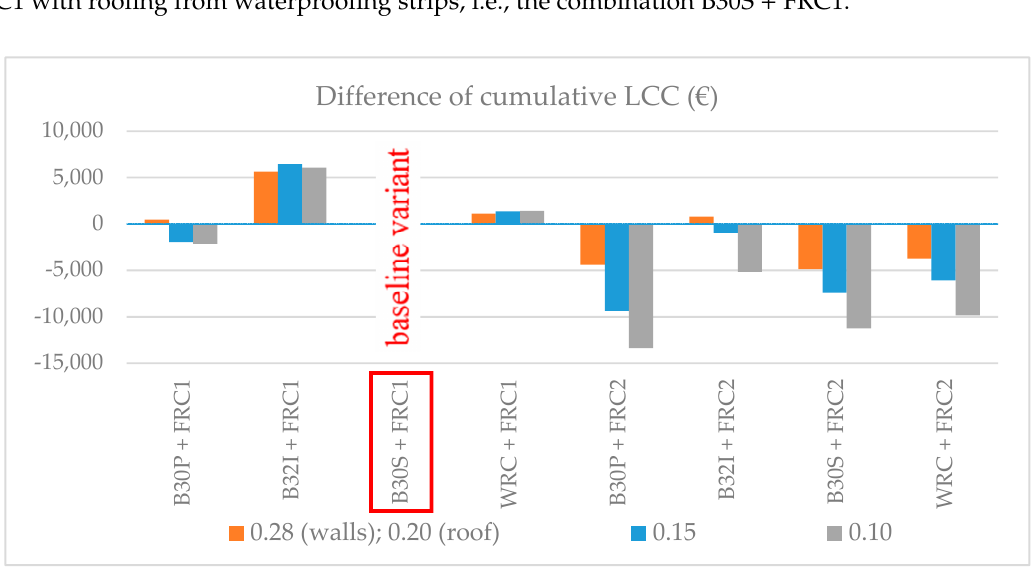
Figure 8. Difference of cumulative LCC according to baseline variant. Figure 8. Di ff erence of cumulative LCC according to baseline